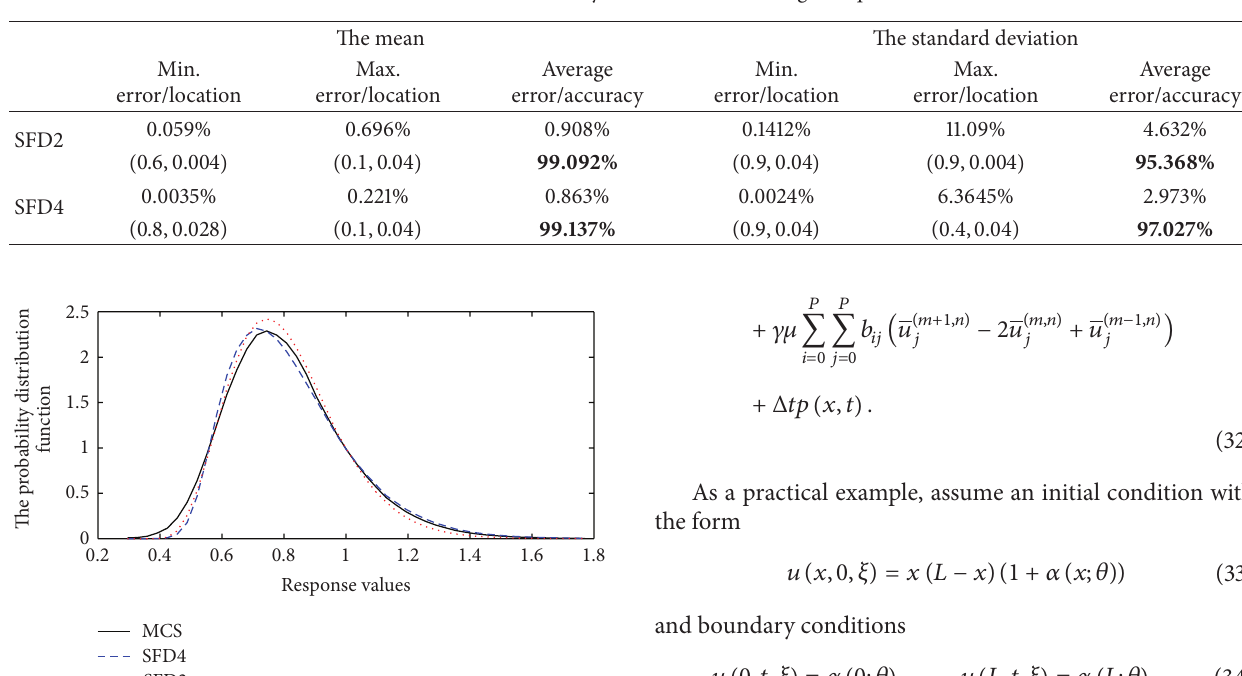
Table 2: Errors and accuracy for the stochastic Burger’s equation.